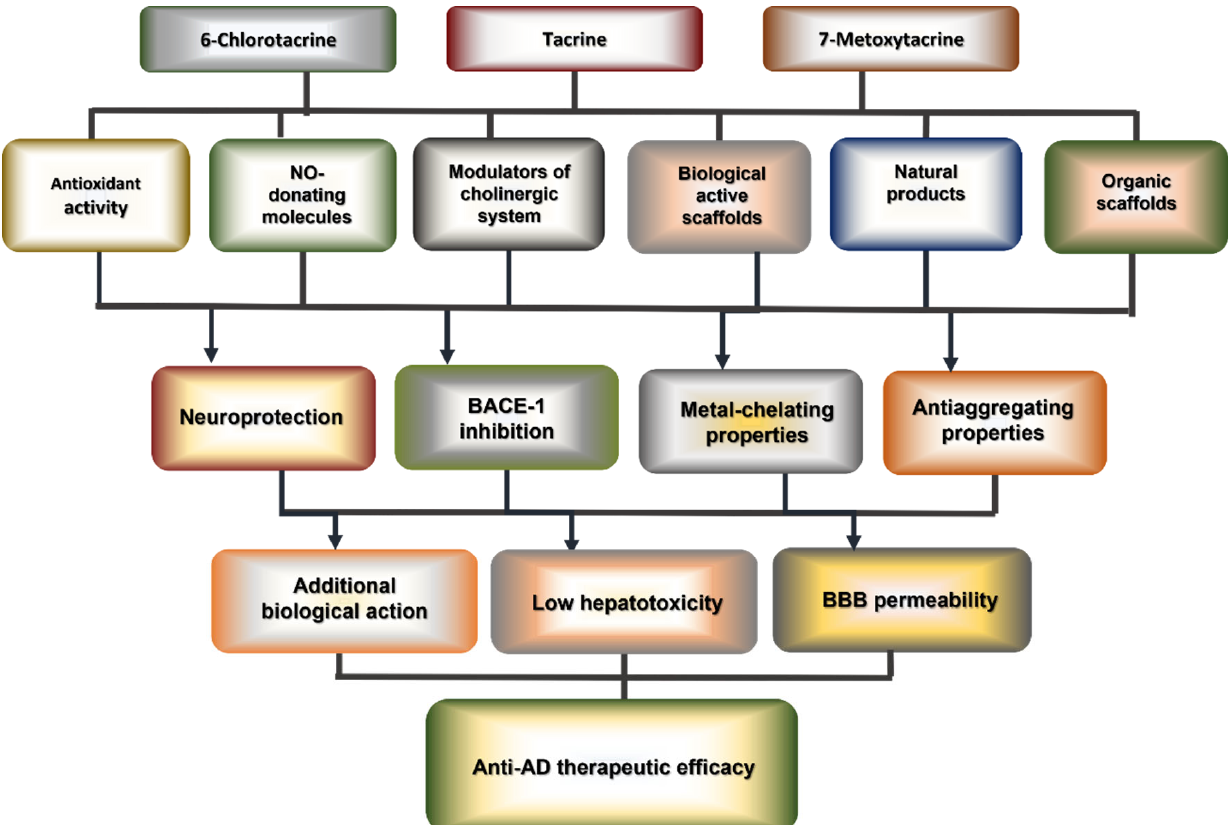
Figure 3. THA ‐ based hybrids with various biological activities, summarized in this review. Figure 3. THA-based hybrids with various biological activities, summarized in this